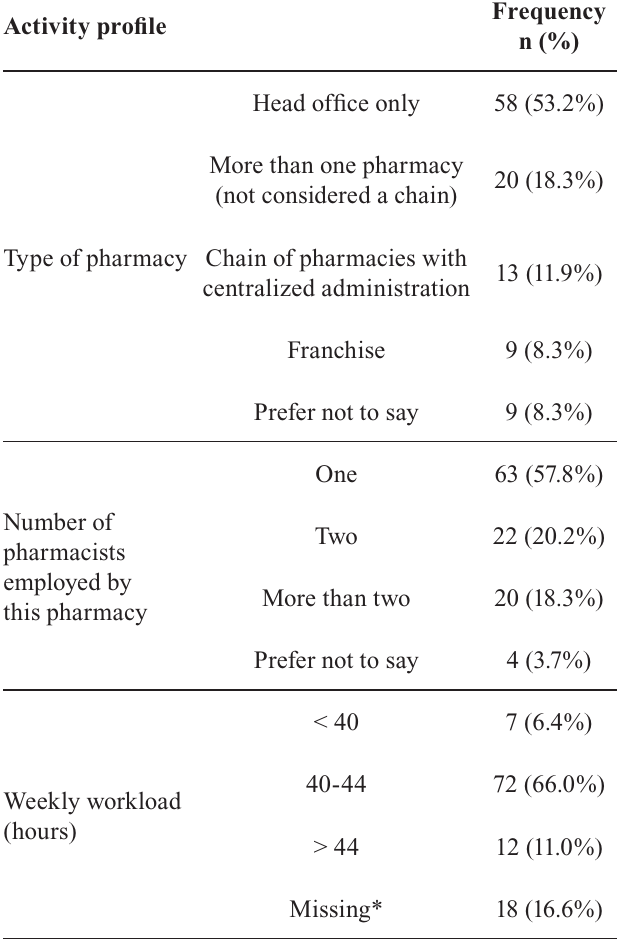
TABLE II - Professional activity profile of pharmacists in charge of community pharmacies in the metropolitan region of Belo Horizonte-MG (n = 109;